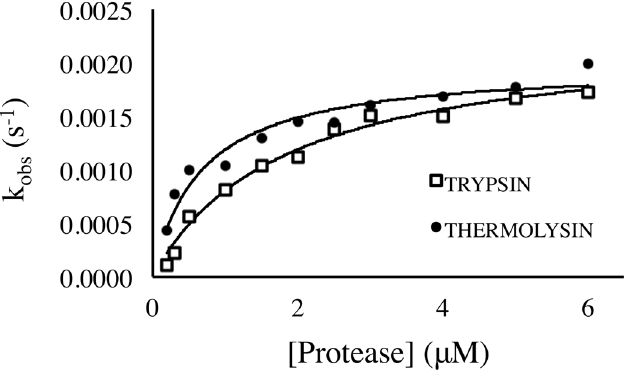
Fig 5. Unfolding kinetic constant derived from limited proteolysis of HLL. A range of concentrations of trypsin (A) and thermolysin (B) are used and degradation is followed by tryptophan fluorescence emission at 330 nm. The fits are to Eq 5 as indicated in the